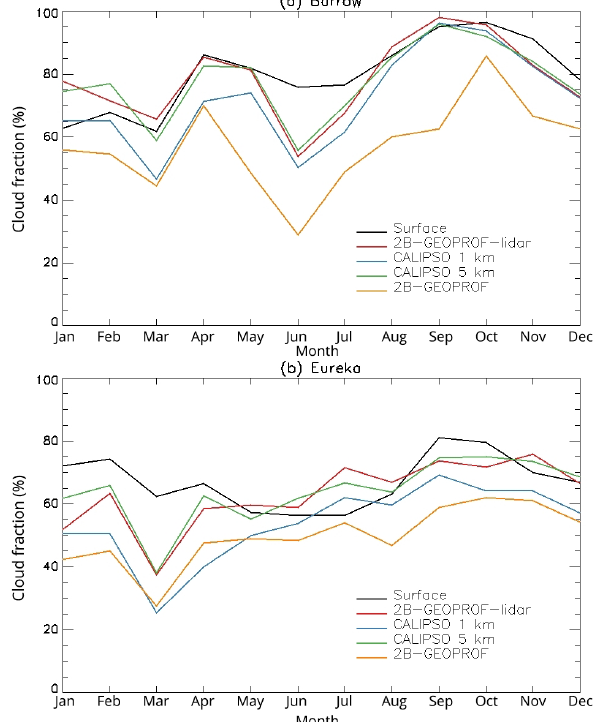
Figure 6. Mean cloud fraction above 960m only, clouds below 960m only, and clouds below and above 960m from surface ob- servations at Barrow (top) and Eureka (bottom) for